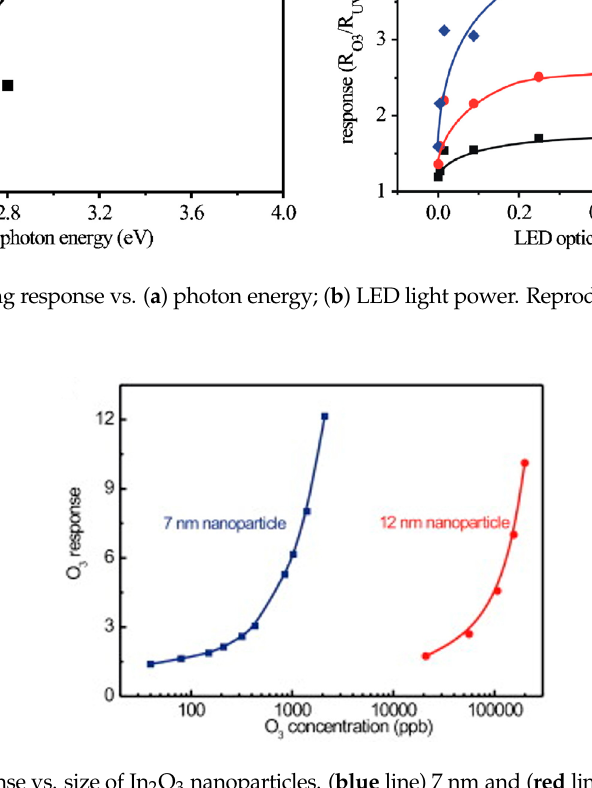
Table 3. Summary of key reported work on light-activated gas sensor based on metal oxides nanoparticles.